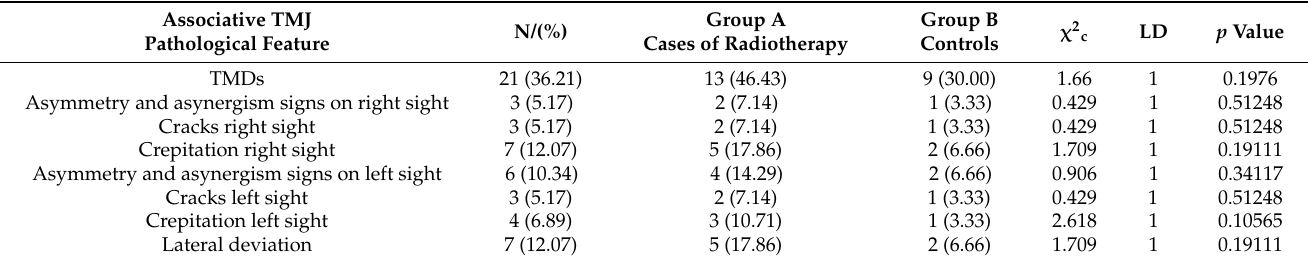
Table 7. The TMJ-associated pathological conditions of the study groups.